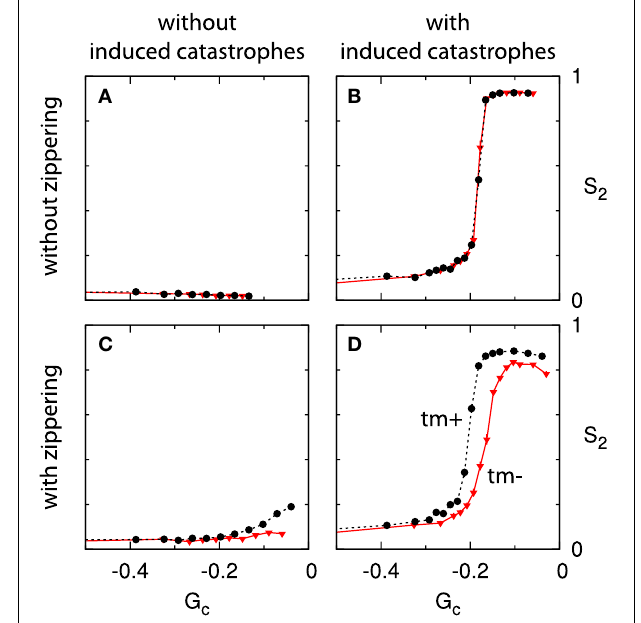
FIGURE 11 | Effect of zippering, induced catastrophes and treadmilling on alignment. Each panels (A–D) shows two G c - S 2 curves, comparing systems with (tm+; dashed black line) and without (tm-; solid red line) minus end treadmilling. Comparisons between adjacent panels illustrate the effect of induced catastrophes (columns) and zippering (rows). The simulations for non-interacting microtubules (A) were not performed for values of G c very close to 0 due to diverging numbers of microtubule trajectories. Because alignment cannot occur in the absence of interactions this limitation is not significant. All points are the average of n = 50 independent runs, evaluated at t = 20h. Standard errors of the mean are shown, but smaller than the data markers for most